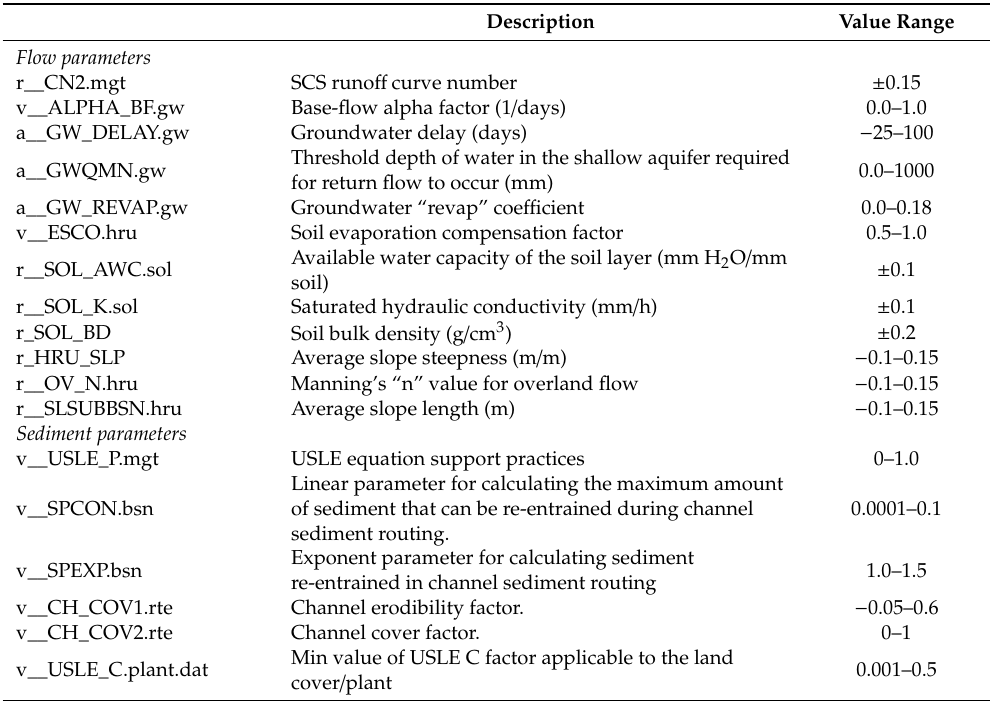
Table 2. Selected flow and sediment calibration parameters and their